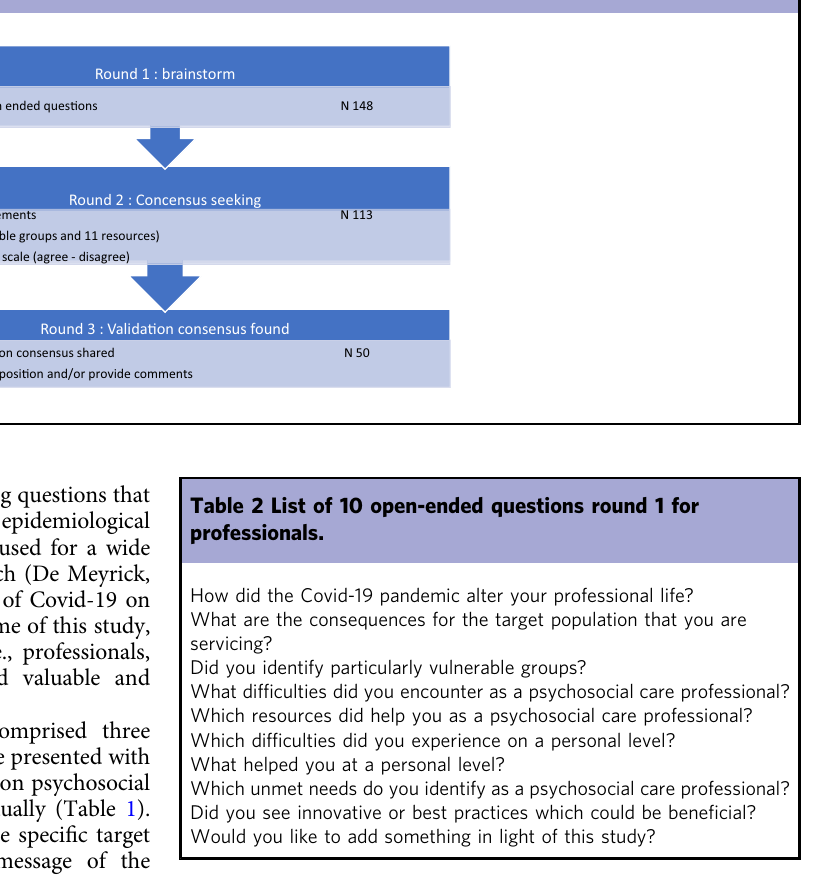
Table 1 Flow diagram illustrating the three rounds and number of experts involved.